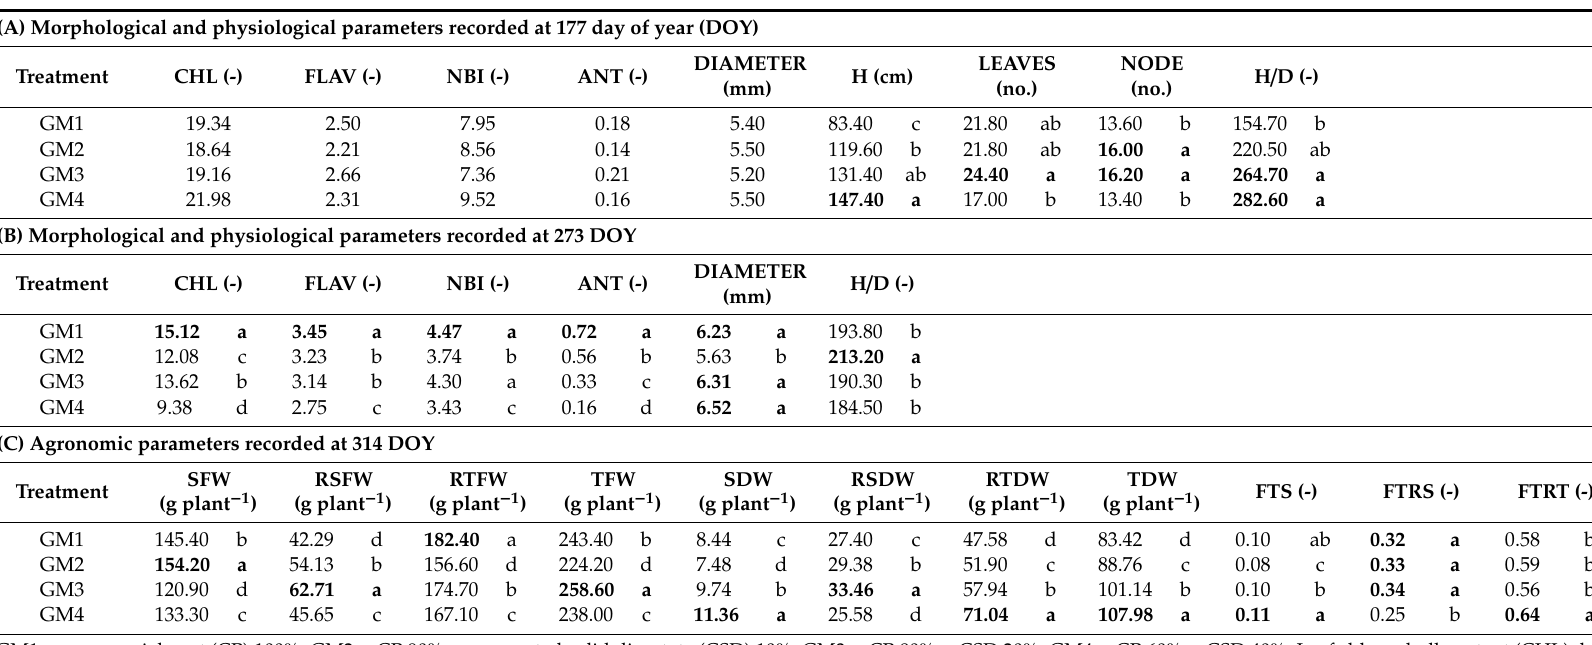
Table 6. Parameters recorded on two-year-old vines grown on growing media containing composted solid